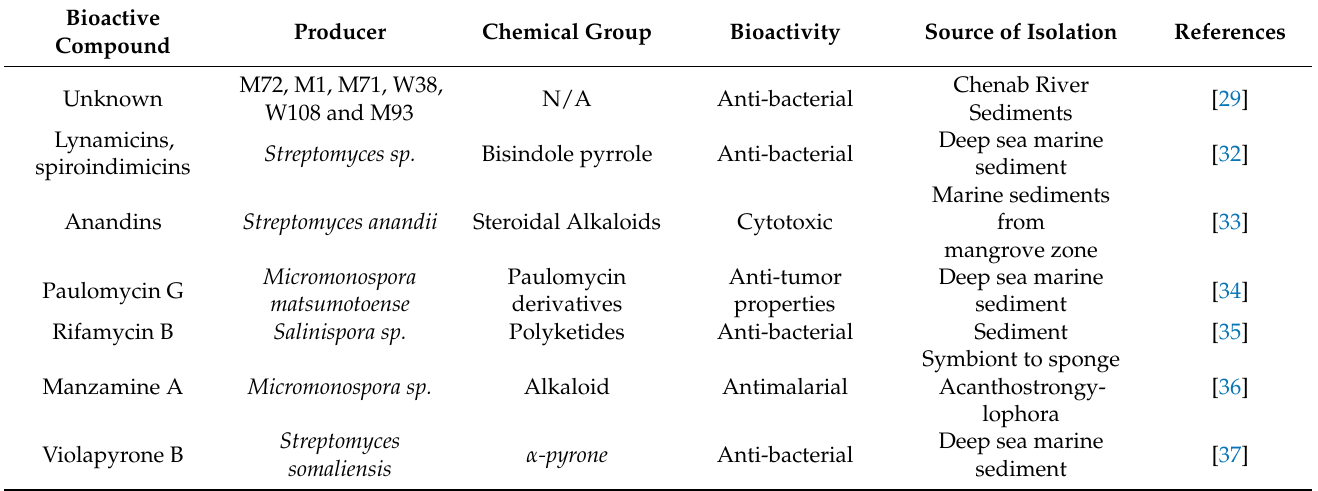
Table 1. List of bioactive compounds, producers, source of isolation and screening for their bioactivity isolated from aquatic and marine